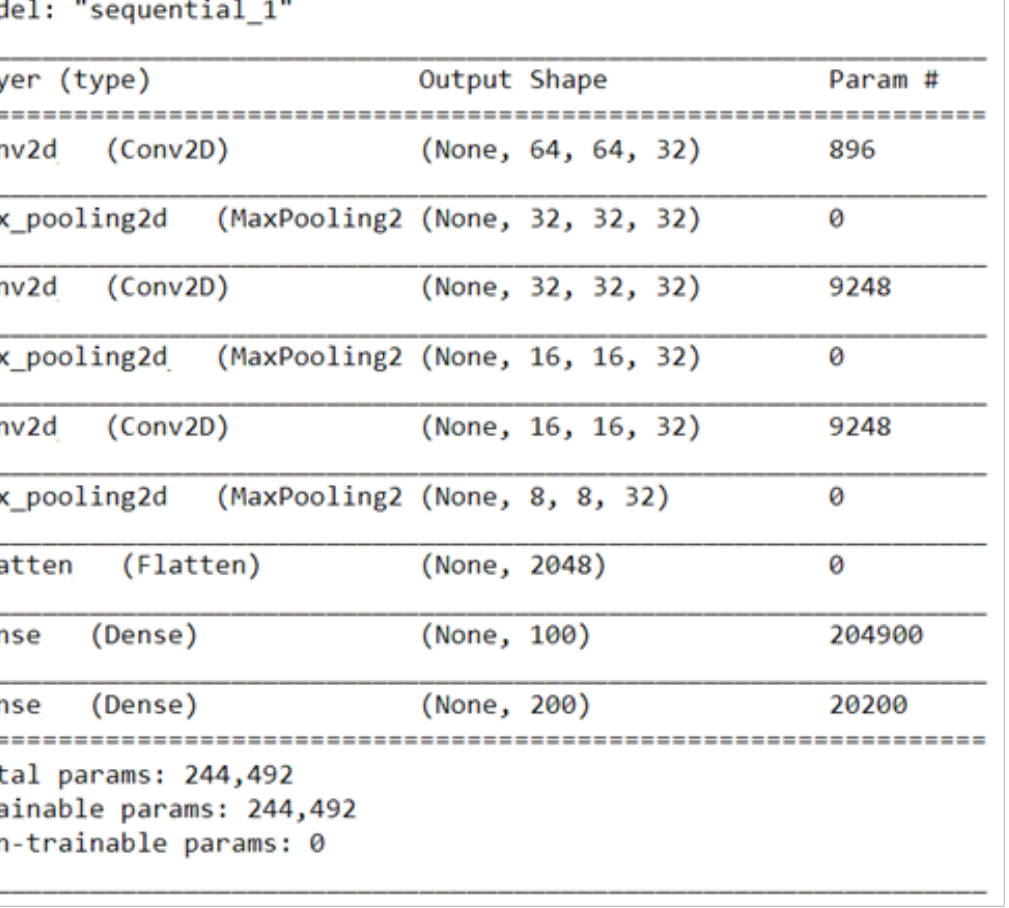
Figure 3. The basic architecture of the designed CNN.